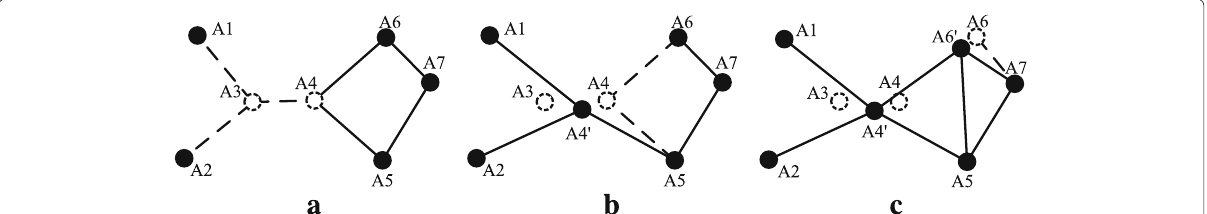
Fig. 5 An example HCR cascading node motion. a Node A3 failed and node A4 is selected to move. b Node A4 moves to A4 ’. c Node A6 moves to A6